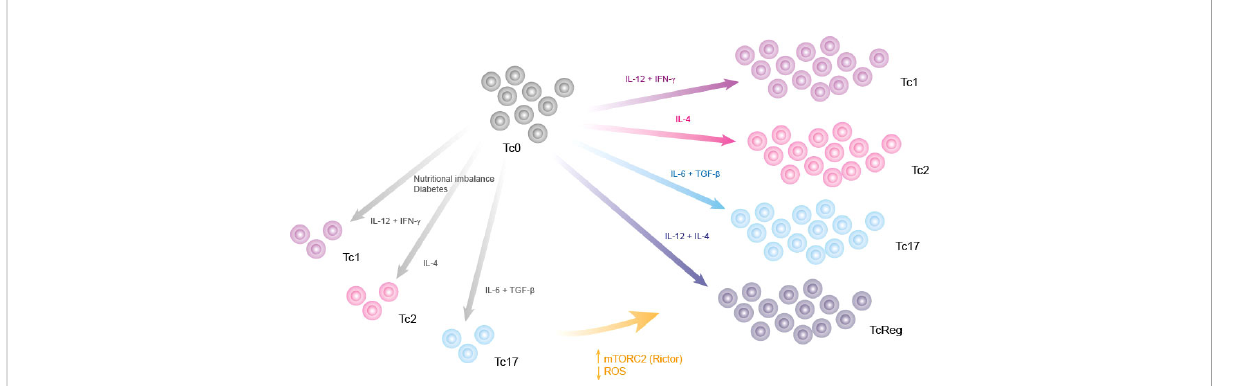
FIGURE 6 Graphical summary. Nutritional imbalances such as chronic consumption of alcohol, high fat diets, diabetes and high consumption of sugar impair the differentiation of CD8+ T lymphocytes. This deregulation of effector phenotype might be caused by an increase of ROS, which can be neutralized by targeting its production, directly with SOD stimulators or indirectly by activating